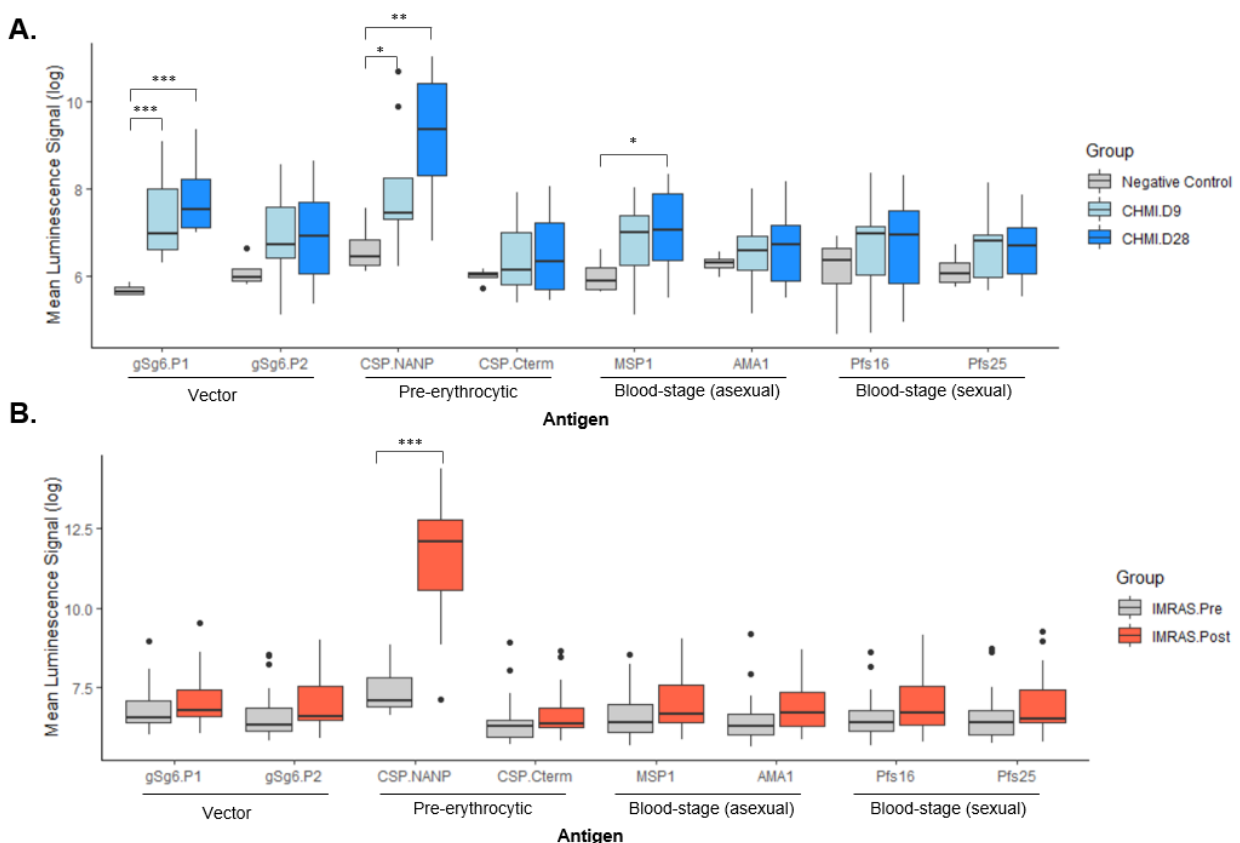
Figure 2. Specific antibody profiles after CHMI and IMRAS. ( A ) Malaria naïve volunteers were exposed to five infectious bites of P. falciparum- infected Anopheles stephensi mosquitoes in a controlled human malaria infection (CHMI, n = 12). All volunteers developed malaria by day 11 post exposure and required treatment with Malarone™. ( B ) Malaria naïve volunteers were immunized with irradiated whole sporozoites (IMRAS), and samples were collected before (pre) and after (post) immunization. All sera were tested at a 1:500 dilution. Asterisks indicate statistical significance (* p < 0.05, ** p < 0.01, *** p < 0.001). Black dots represent outliers.